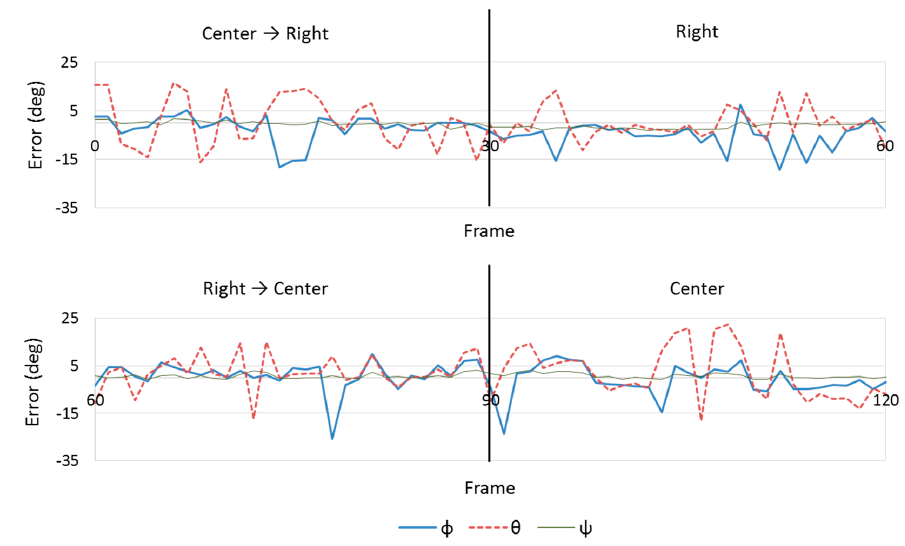
Figure 9. Rotation errors when the head moved horizontally.